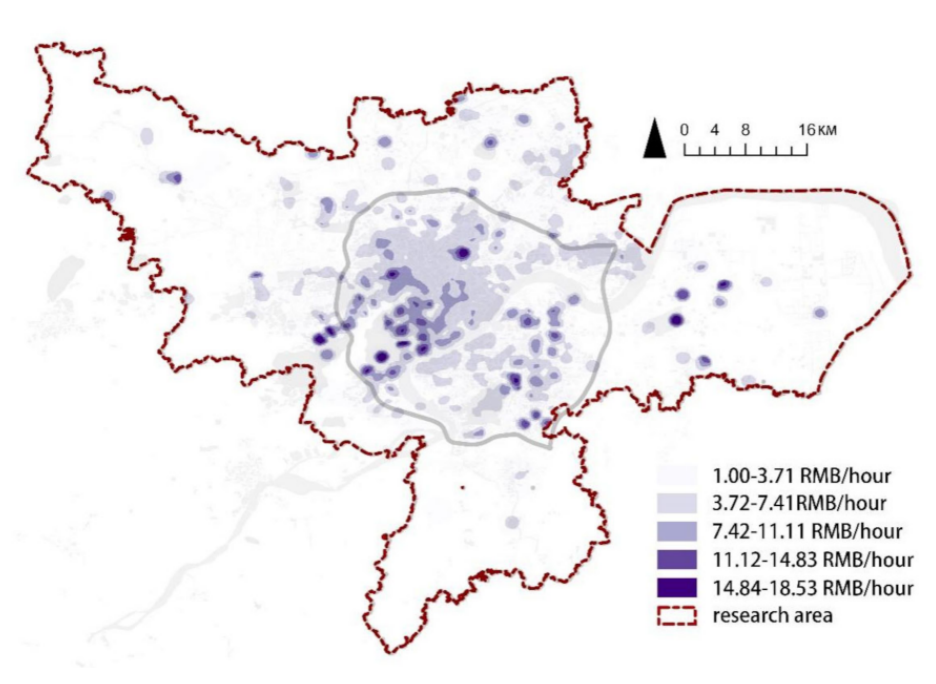
Figure 7. The kernel density of parking lots’